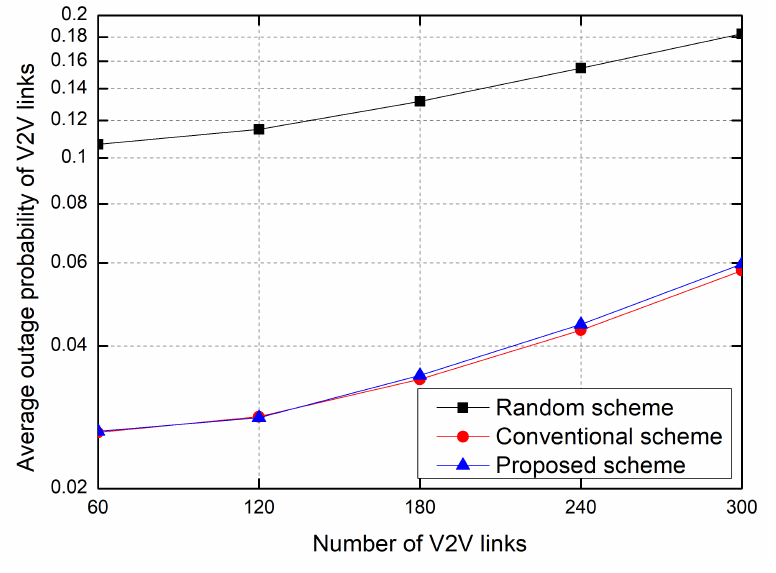
Figure 8. Average outage probability of V2V